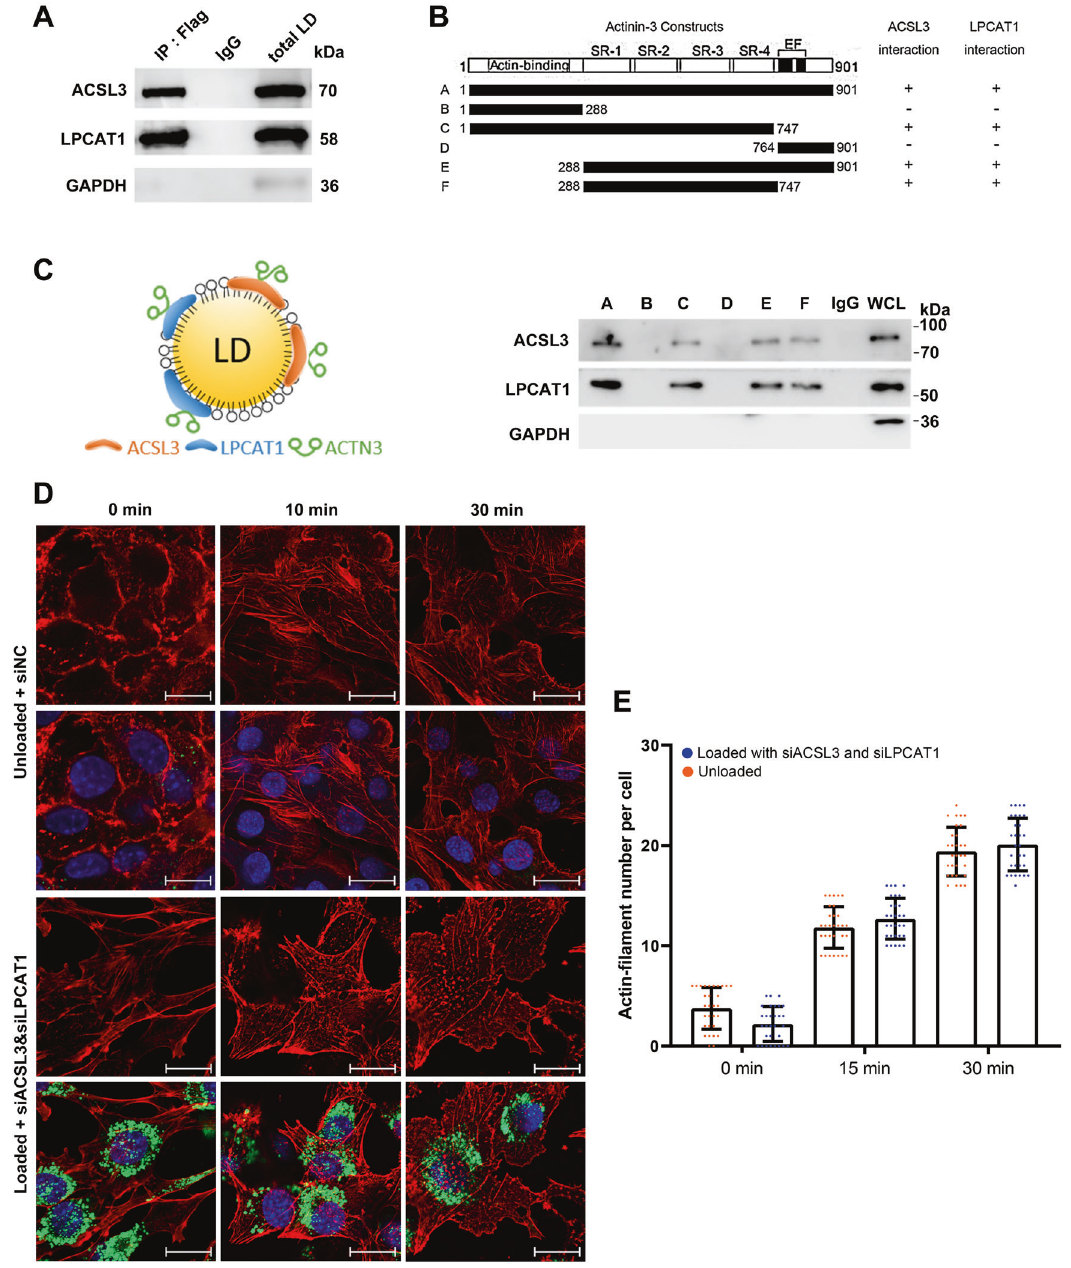
Fig. 4 LD proteins ACSL3 and LPCAT1 recruit actinin by binding SR protein domains. A Co-IP veri fi cation of ACTN3-ACSL3 and ACTN3- LPCAT1 interactions. B ACTN3 was truncated according to the domain. The Co-IP detection of the interactions of ACSL3/LPCAT1 and different ACTN3 domains. C The schematic diagram of ACTN3 recruited on LD. D The rate of actin- fi lament remodeling in loaded cells with siACSL3 and siLPCAT1 and unloaded cells, bar, 20 μ m. E The count of micro fi lament number per cell. * p < 0.05. Results are from three technical repeats ( N = 3) for a representative of three biological repeats ( N =